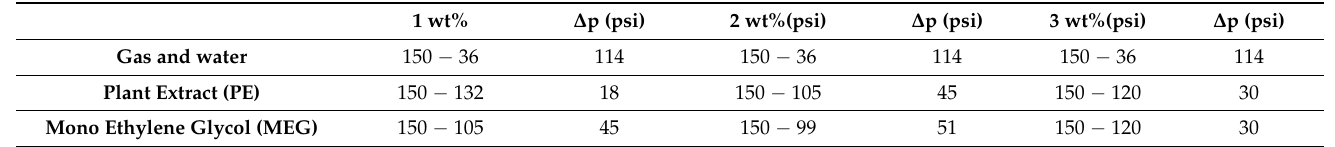
Table 2. Initial and Final pressure values and change in pressure for Gas and Water, 1 wt%, 2 wt%, and 3 wt% of Plant Extract (PE) and Mono Ethylene Glycol (MEG). 1 wt% ∆ p (psi) 2